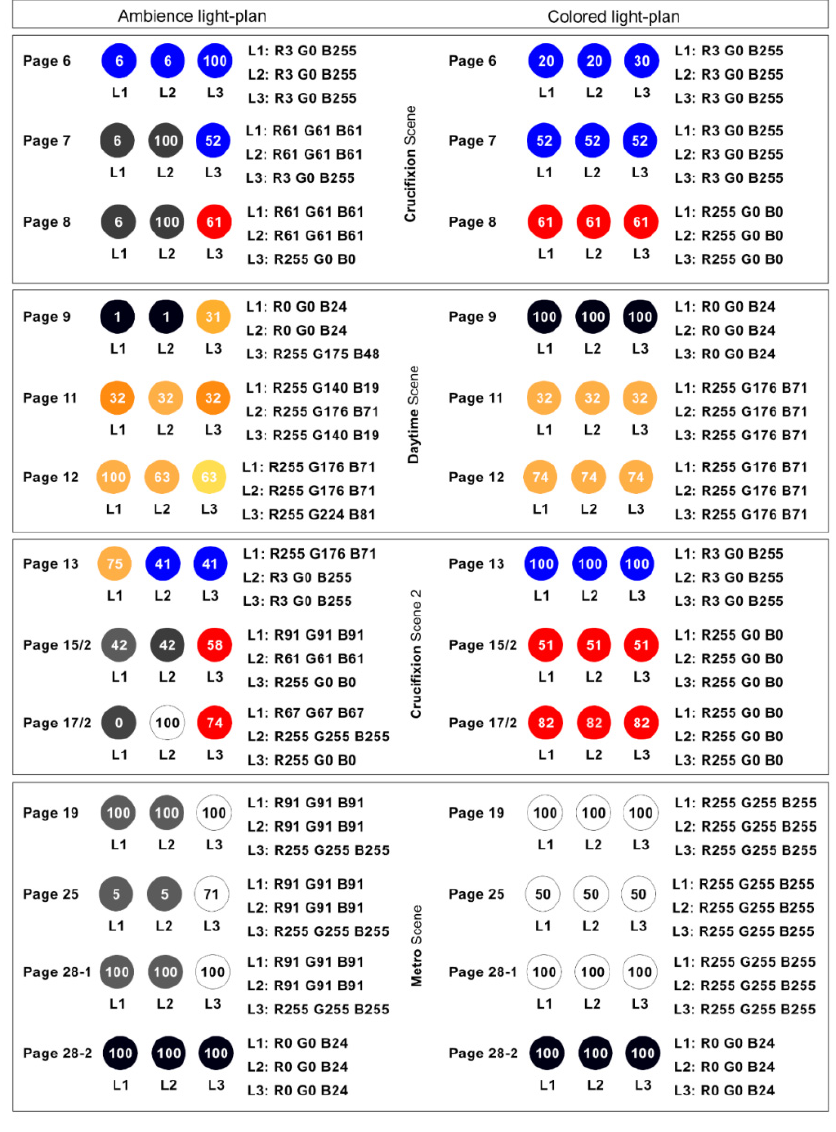
Figure 3. Ambience and colored light plan. Note: Lx = Light number x, R = Red, G = Green, B = Blue. The numbers behind R, G, and B are the RGB values (0,0,0 is black and 255,255,255 is white). The numbers in the circles indicate the brightness of that color between 0 and 100%.